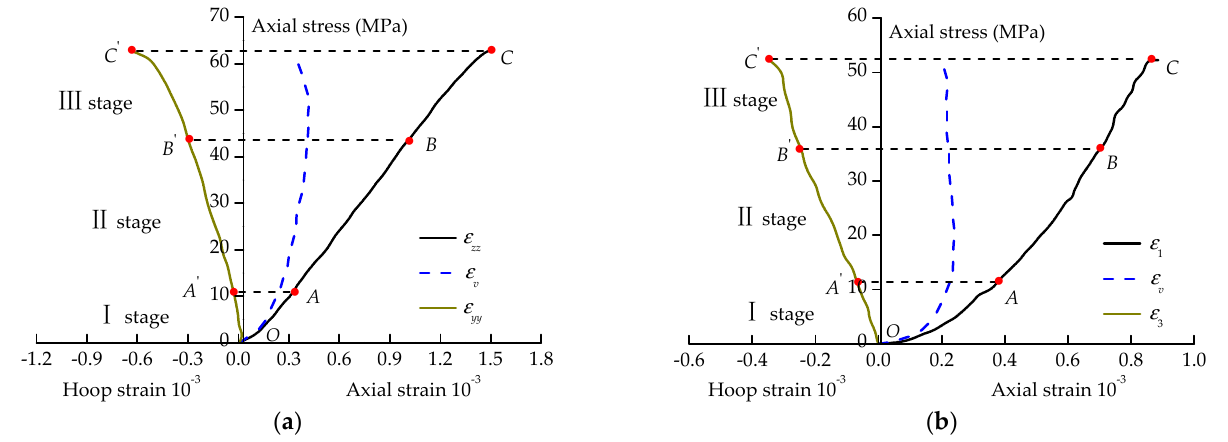
Figure 4. Stress − strain curves under vertical loading: ( a ) Gray samples; ( b ) Cinerous samples.